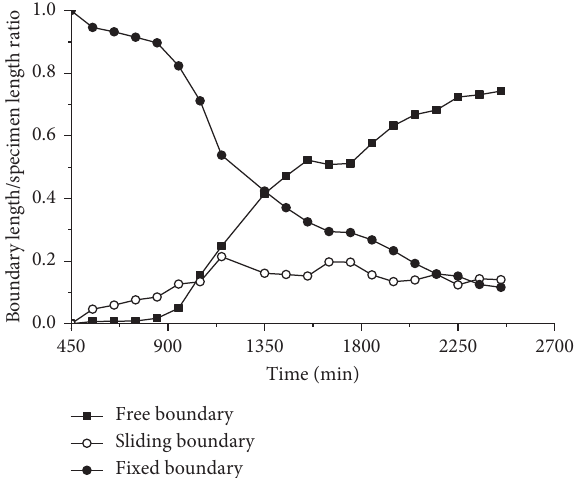
Figure 8: The variations in the ratio of the length of the boundaries to the total length of the specimen as a function of time.